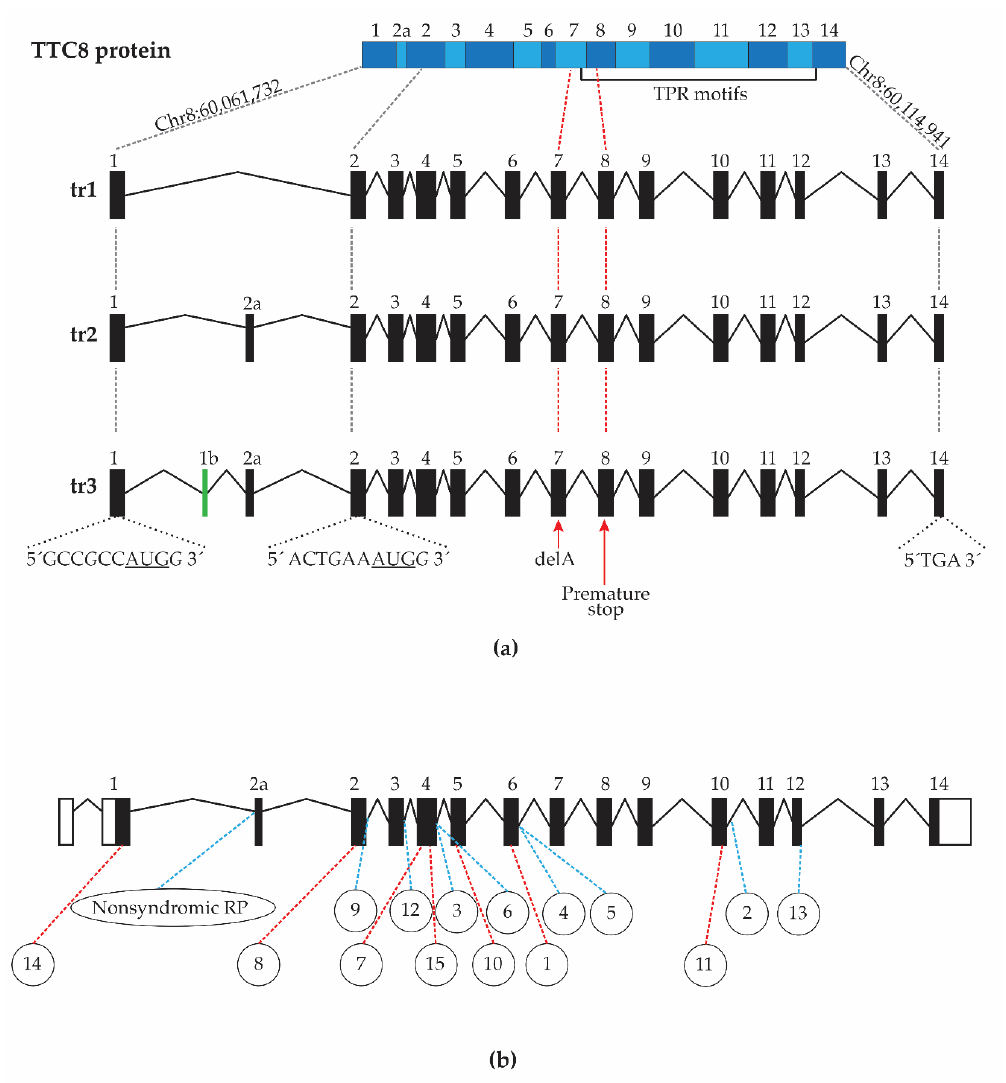
Figure 7. Retinal isoforms of canine the TTC8 gene and human variants associated with Bardet-Biedl syndrome (BBS). ( a ) On top, a schematic representation of the TTC8 protein including the approximate location of the TPR motifs, and below, the three identified canine retinal transcripts. The black dashed lines indicate the two alternative TIS including the Kozak consensus sequence, and the translation termination site in exon 14. The red dashed lines indicate the 1 bp deletion of adenine in exon 7 and the premature stop codon in exon 8. ( b ) An overview of identified human TTC8 coding variants (red dashed line) and splice-site variants (blue dashed line), see Table S6. The positions of the human mutations are based on the reported positions in the original publications, and the exon numbering may therefore differ from the positions in the presented transcript (ENST00000345383.9). tr1: transcript 1, tr2: transcript 2, tr3: transcript 3, TPR: tetratricopeptide repeat, TIS: translation initiation site.